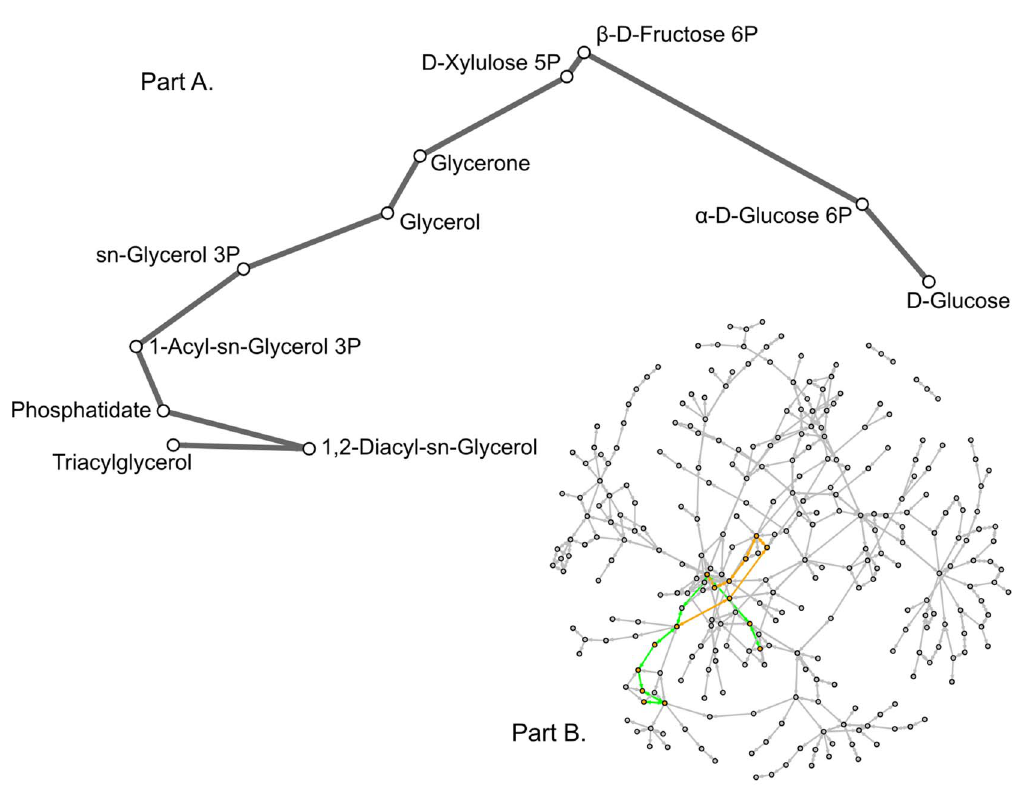
Figure 2. The first shortest path found in our graph between glucose and triacylglycerol using breadth-first search. A. This is the detailed view of the path showing the names of the compounds involved at each step. B. The shortest path is highlighted in green on the full graph to show its location. In contrast, the path presented in KEGG is highlighted in orange. The shortest path contains 11 compounds while the KEGG path contains 15 compounds.